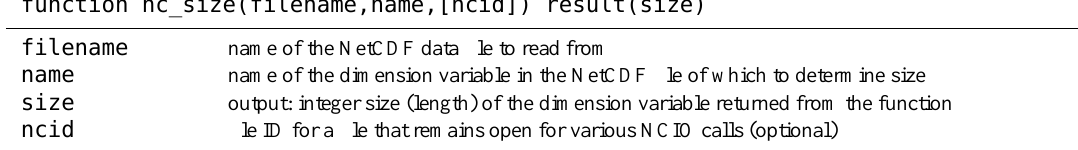
Table A2. Function call and argument descriptions for nc_size .